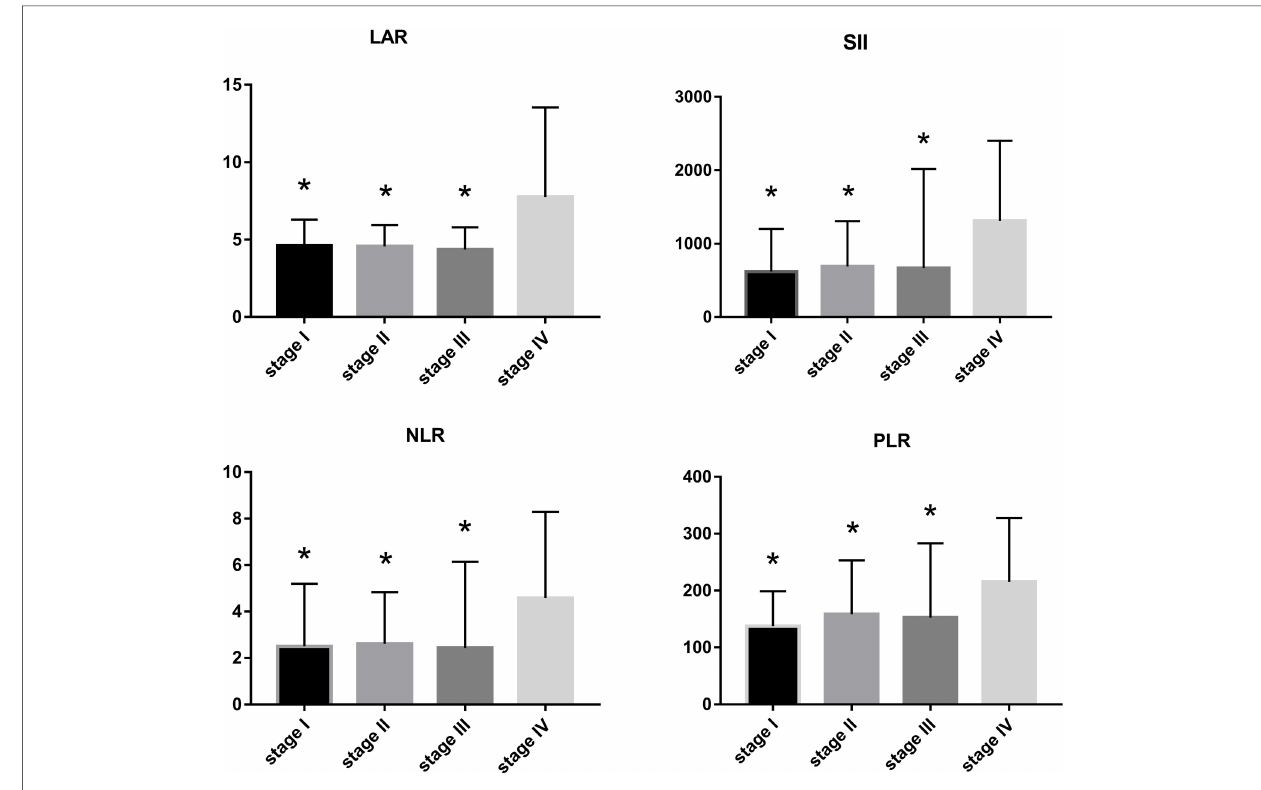
FIGURE 2 LAR, NLR, PLR and SII levels of CRC patients in different stages compared with stage IV, * p <0.05, compared with the TNM stage IV